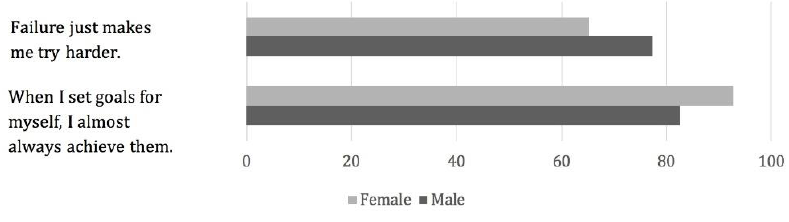
Fig. 3. Male and female students’ levels of self-efficacy and